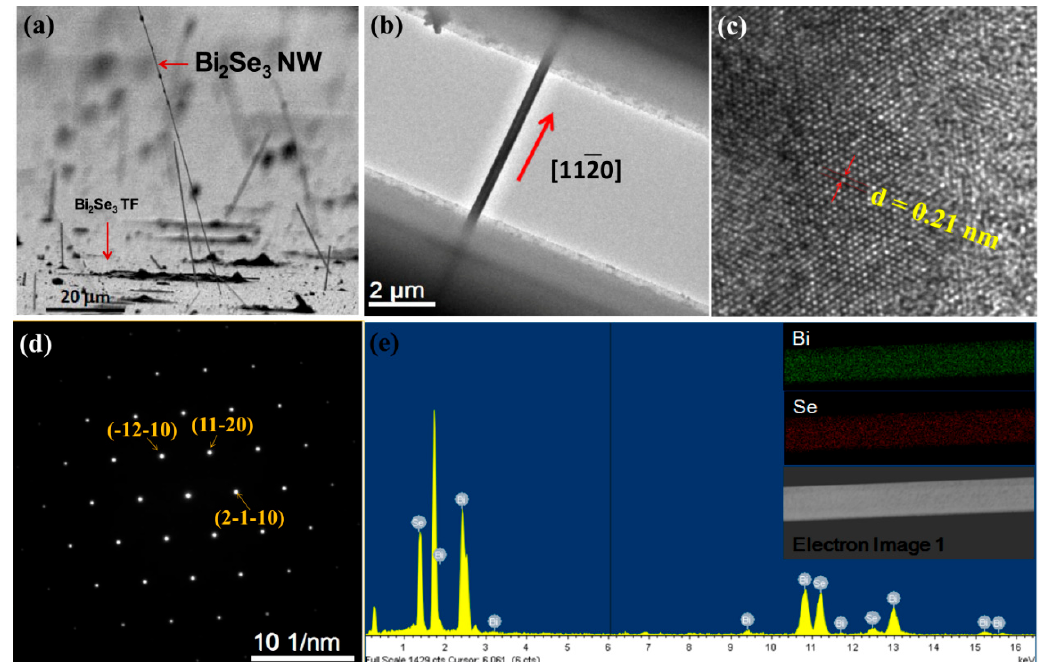
Figure 1. ( a ) SEM image (top view) indicating that all Bi 2 Se 3 NWs grew several micrometers in length from the surface of the Bi 2 Se 3 TF; ( b ) TEM images of a single-crystal Bi 2 Se 3 NW suspended on a Si 3 N 4 microchip following electrode formation by using a FIB that served as the TEM holder; ( c ) HR-TEM image of the NW shown in ( b ), where the distance between crystal faces is 0.21 nm; ( d ) the SAED pattern (at the [0001] zone axis), confirming that the single-crystalline NWs grew in the [11–20] direction; and ( e ) EDS spectrum of a Bi 2 Se 3 NW (the inset shows the EDS mapping image of a NW).